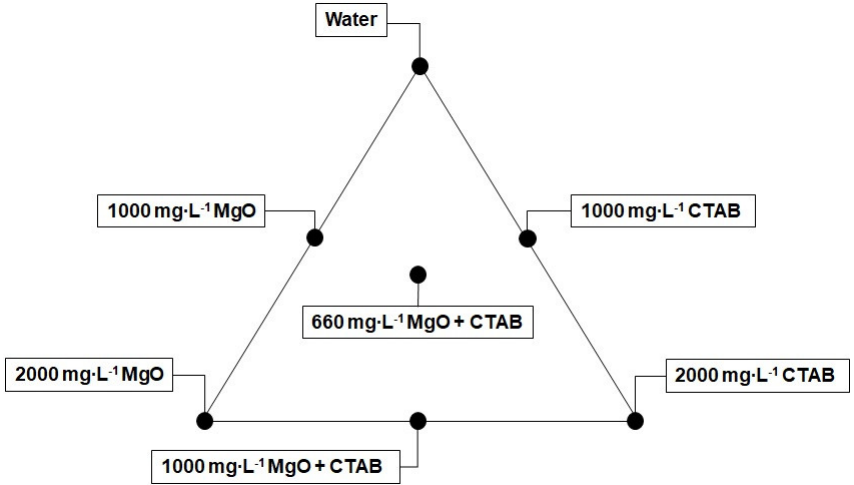
Figure 2. Three components simplex − centroid mixture design proposed to evaluate the synergistic effect between MgO and hexadecyltrimethylammonium bromide (CTAB) in the system I with different mass fractions up to 2% using deionized water as the carrier fluid.